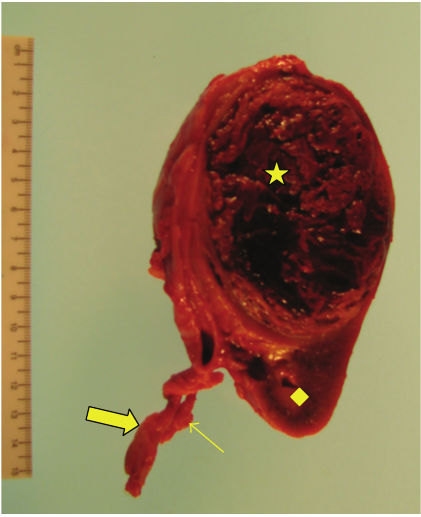
Figure 4: Coronal cut of pelvic/ectopic kidney showing a fairly well circumscribed 8 . 3 × 6 . 9 × 6 . 8 cm reddish-brown markedly hemorrhagic mass (star), consistent with papillary renal cell carcinoma. Other structures include normal renal parenchyma (diamond), ureter (narrow arrow), and left renal artery (thick arrow).